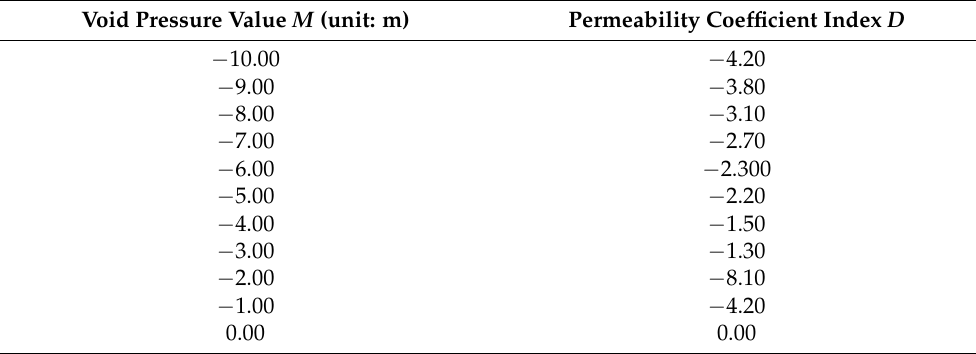
Table 1. Table of Relationship between Void Pressure Value and Permeability Coefficient Index. Void Pressure Value M (unit: m)